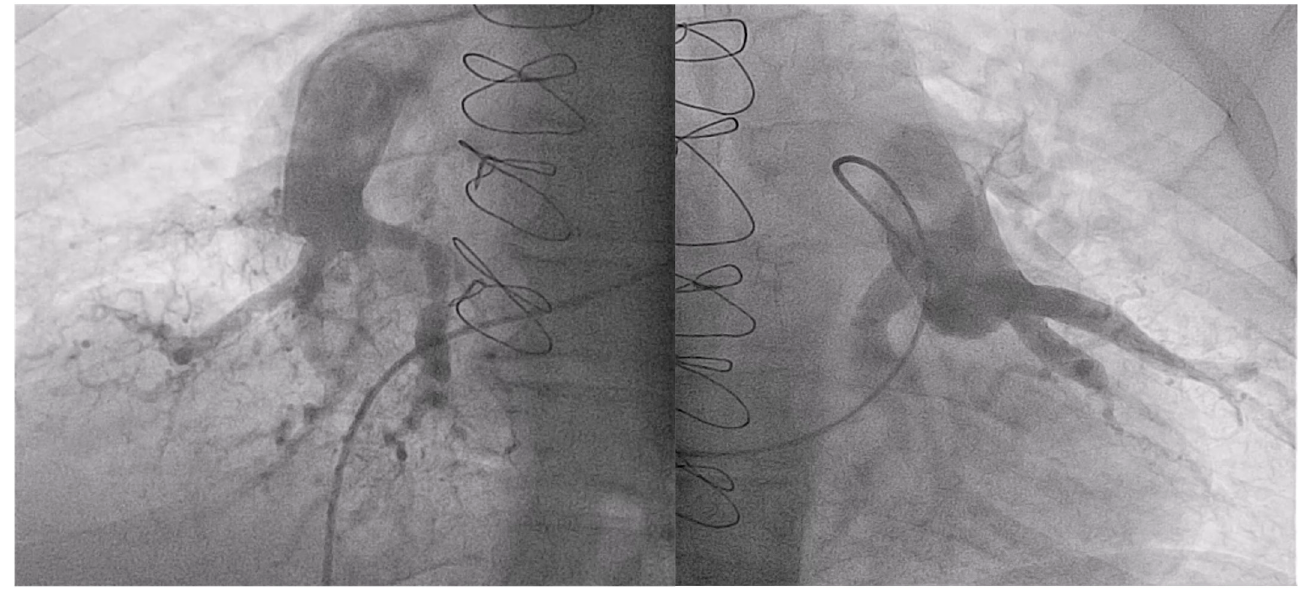
Figure 4. Pouch-like lesions with occlusion of segmental branches in both inferior lobe arteries of a postsurgical patient treated with BPA.